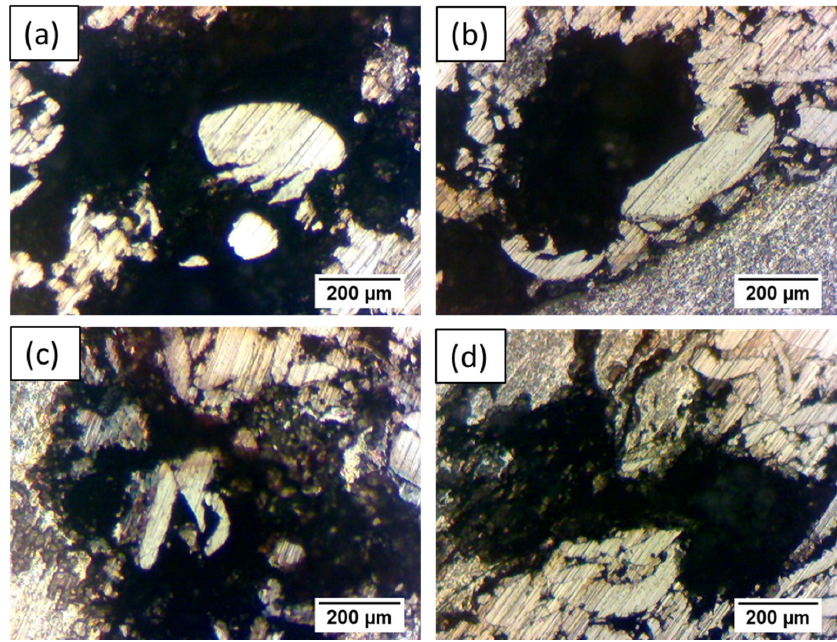
Figure 8. Light microscopy ( LM) images showing the clustered regions of ( a ) specimen 1, ( b ) specimen 2, ( c ) specimen 3, and ( d ) specimen 4.